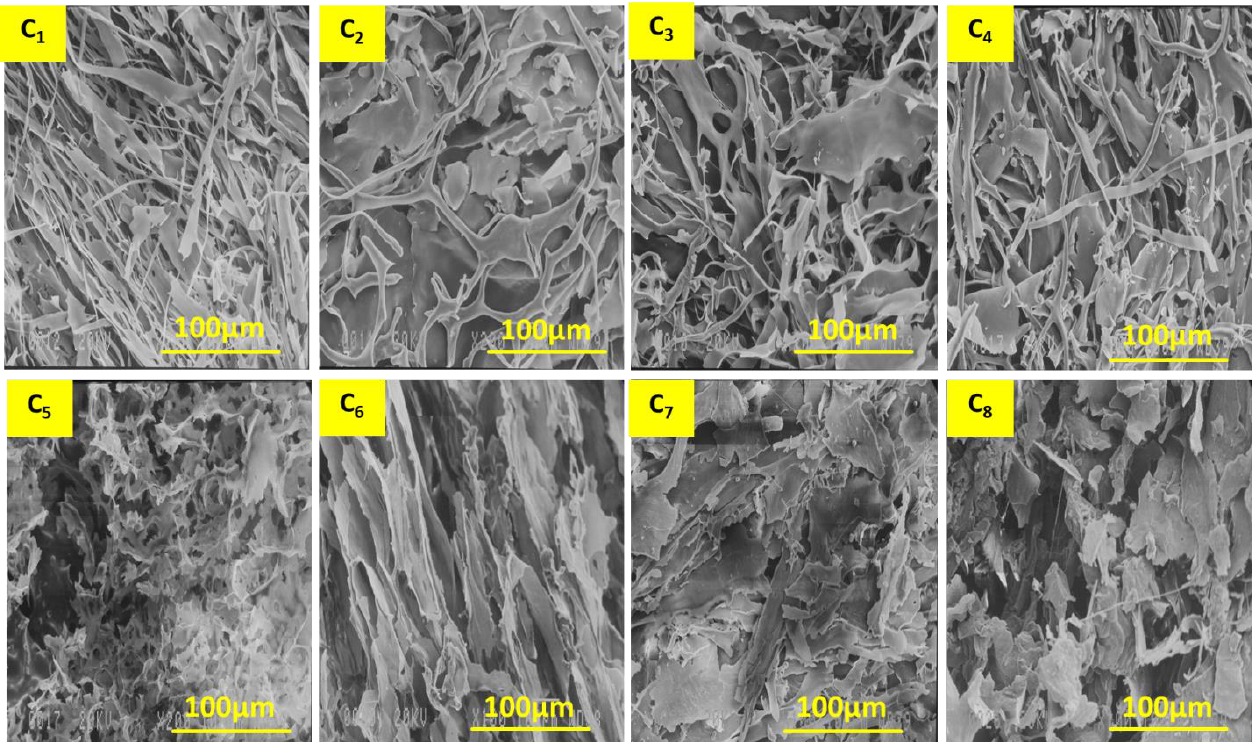
Figure 3. SEM images of the unmodified CNC and modified CNC aerogels with different concen- trations of TEPIC/CA/Urea.